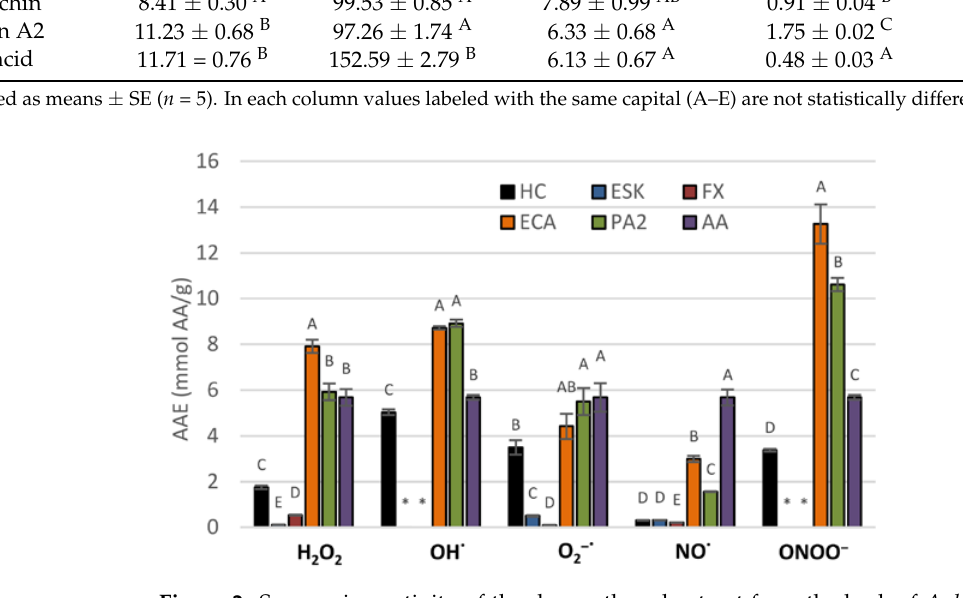
Figure 2. Scavenging activity of the dry methanol extract from the bark of A. hippocastanum and its main constituents towards selected reactive oxygen species (ROS), expressed as ascorbic acid equivalents (AAE). Results presented as means ± SE ( n = 5). For each ROS, the values labeled with the same capital are not statistically different at α = 0.05. Analytes: HC, horse-chestnut bark extract; ESC, esculin; FX, fraxin, ECA, (‒) -epicatechin; PA2, procyanidin A2; AA, ascorbic acid.